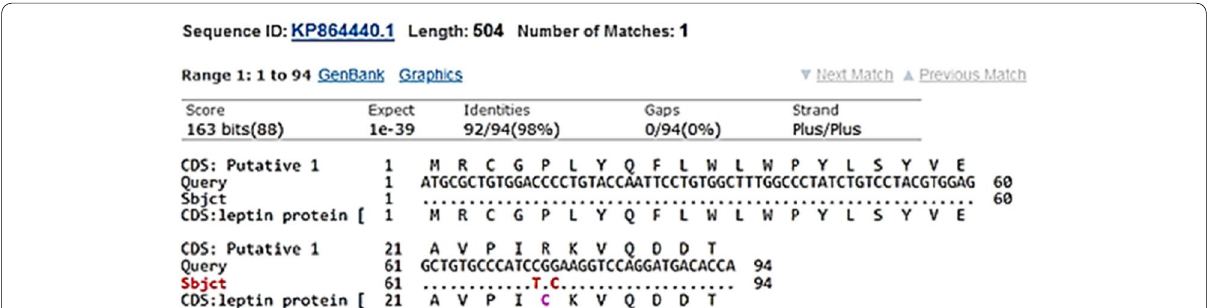
Fig. 3 Detected C73T and G75T SNPs in the amplified LEP sequence and its homologues Bubalus bubalis sequence in the GenBank